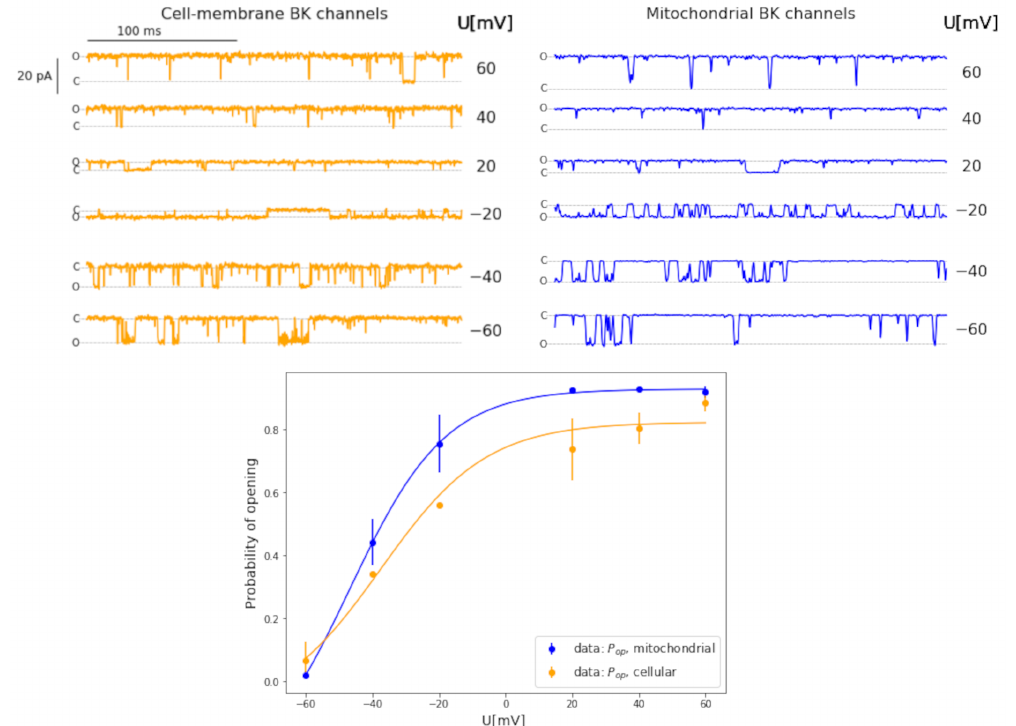
Figure 1. Representative experimental series of single-channel currents recorded on patches from cellular and mitochondrial membranes, and the corresponding voltage-activation curves. The empirical points representing the p op vs. ( U m ) dependence are fitted by a sigmoidal